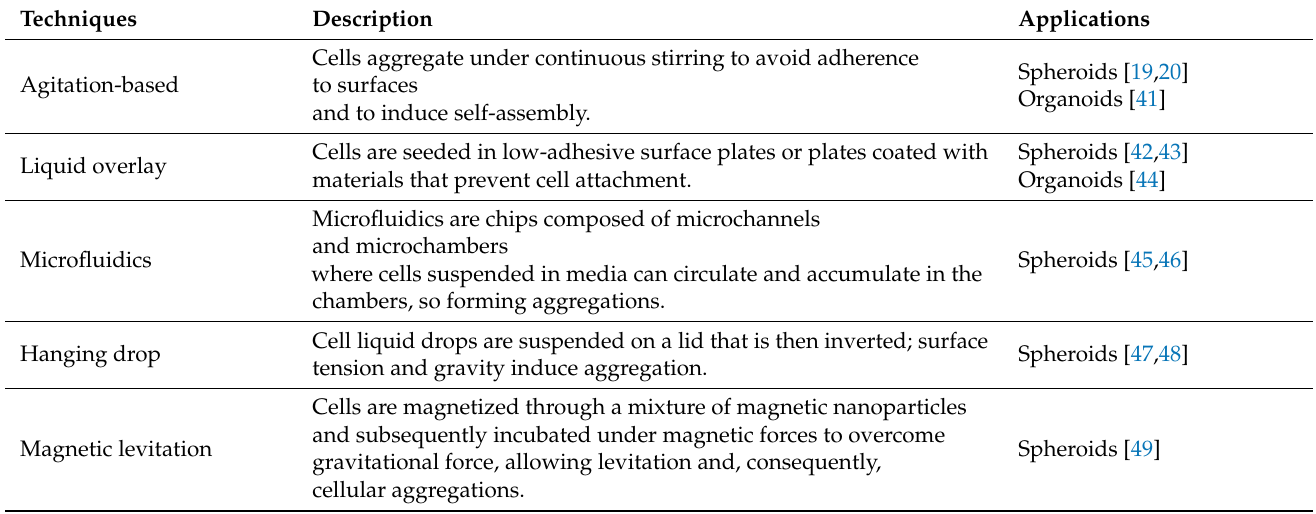
Table 1. Scaffold-free